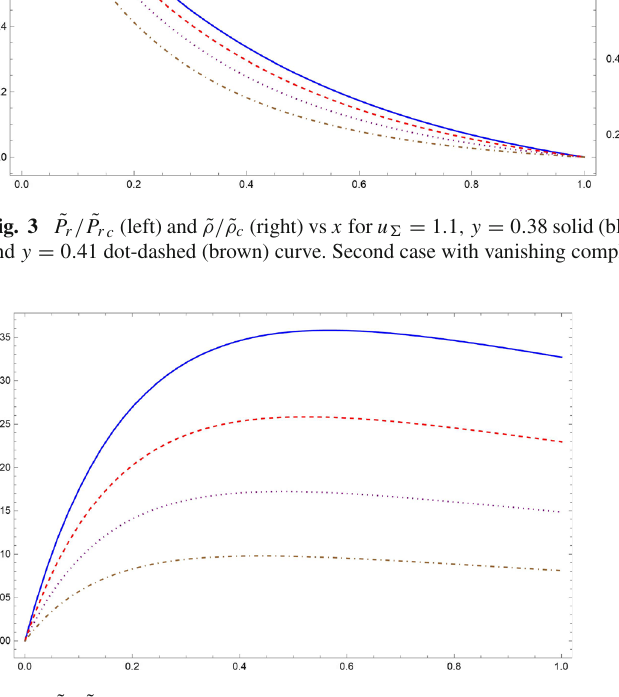
Fig. 5 ˜ v s r (solid) and ˜ v s ⊥ (dashed) vs x for u (cid:5) = 1 . 1 , y = 0 . 38 blue curve, y = 0 . 39 red curve, y = 0 . 40 purple curve and y = 0 . 41 brown curve. Second case with vanishing complexity using F-S as